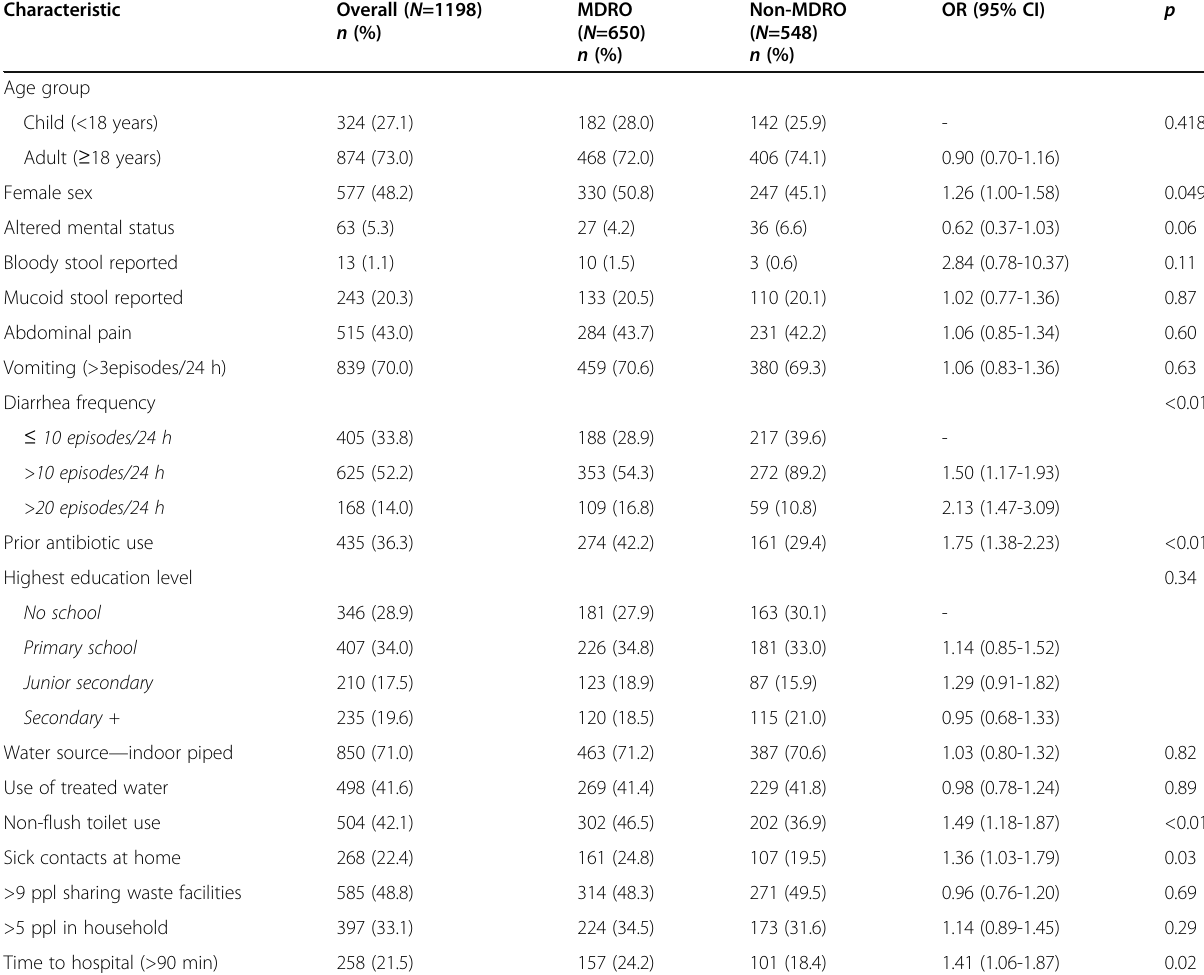
Table 4 Prevalence of categorical variables and association with multidrug-resistant organisms (MDRO) in bivariate analysis Characteristic Overall ( N =1198) n